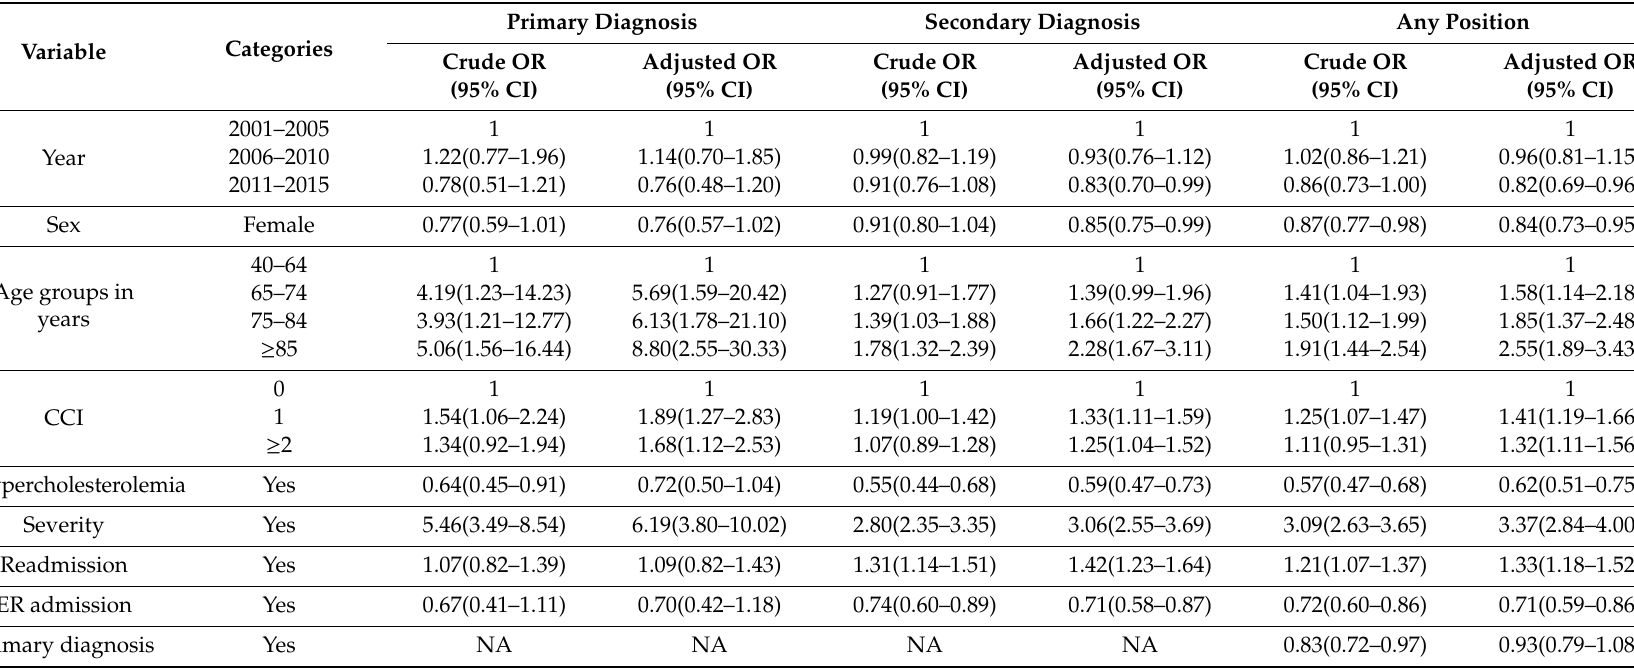
Table 4. Multivariable analysis of factors associated with in-hospital mortality among HF patients with Clostridioides di ffi cile infection (CDI) according to the diagnosis